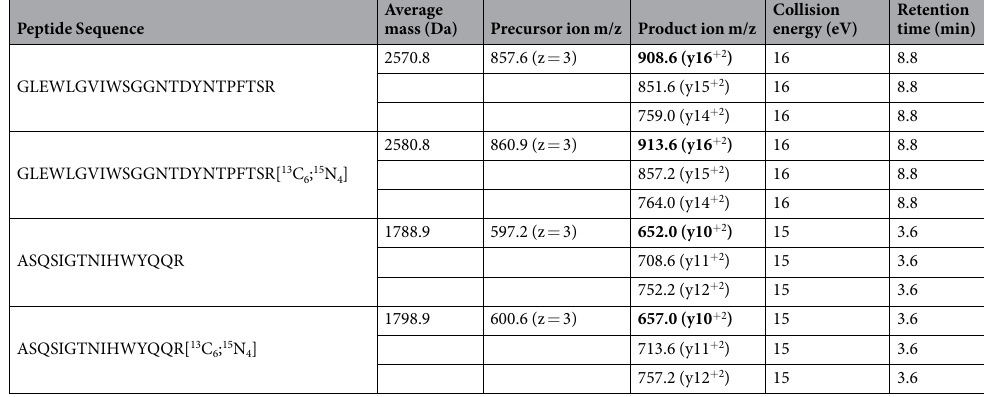
Table 1. MS parameters for SRM detection of HT4 and LT3 peptides as well as corresponding internal standards. In bold: Product ion selected for quantification. Additional product ions are used for